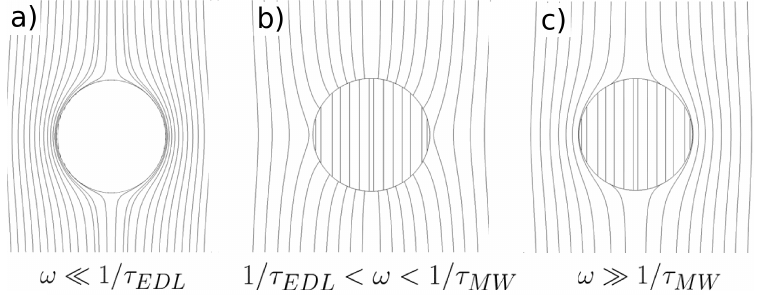
Figure 8. Electric field lines for a semiconducting particle immersed in an electrolyte: ( a ) Signal frequencies much smaller than the reciprocal of the double layer charging time (1/ τ EDL ); ( b ) intermediate frequencies; ( c ) frequencies much higher than the reciprocal of the Maxwell–Wagner characteristic time (1/ τ MW